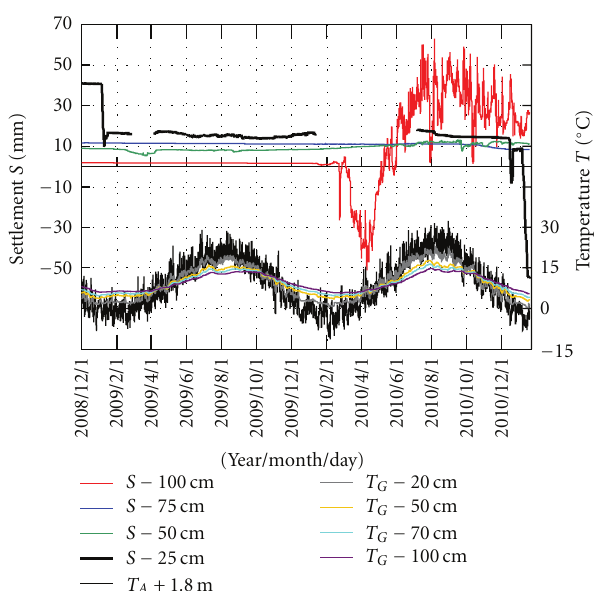
Figure 11: Settlement behavior monitored using settlement gauges.